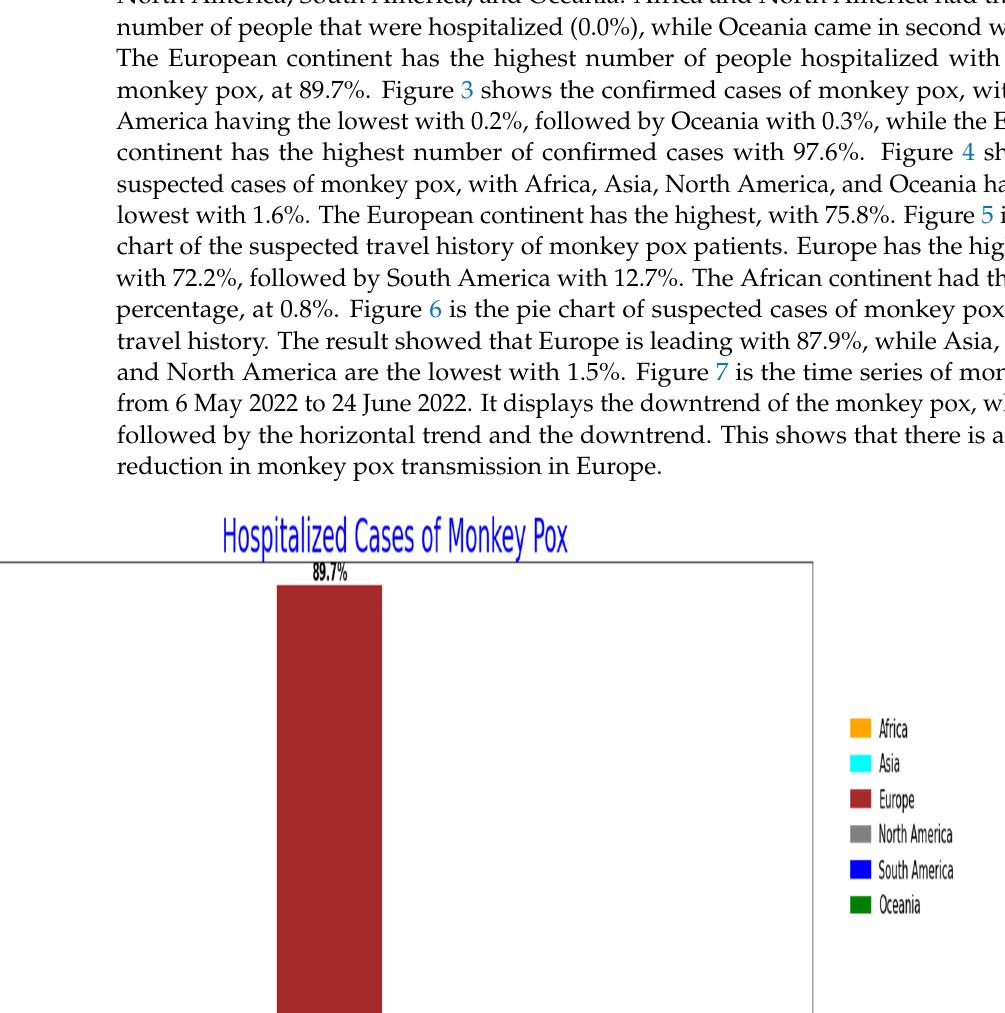
Figure 3. Confirmed Cases of Monkey pox.